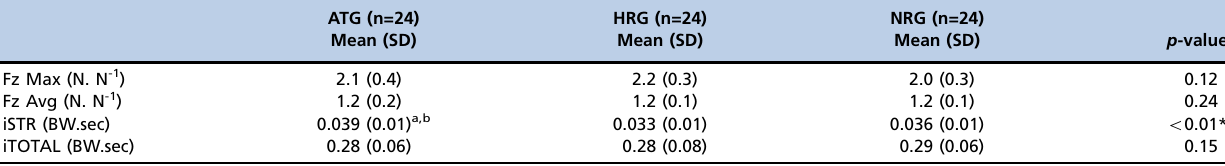
ATG (n=24) Mean (SD)